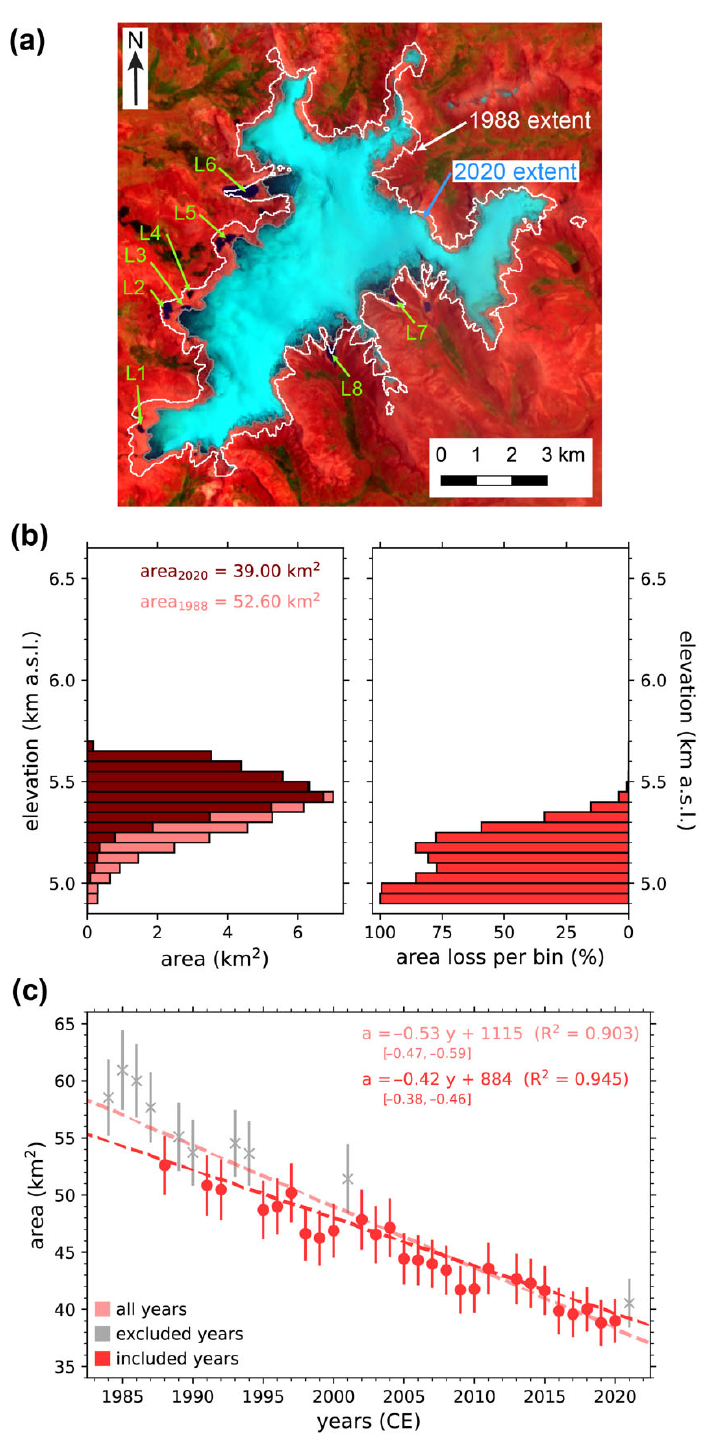
Figure 2. Changes at the Quelccaya Ice Cap ( a ) in map view, ( b ) with respect to elevation in 50 m elevation bins, and ( c ) over time. The Landsat scene for ( a ) is a false-color composite of the scene with the minimum area in 2020 (29 October), and the white outline is the 1988 extent for the scene with the minimum area (3 September). The green arrows indicate eight proglacial lakes (L1 through L8) that have emerged within the 1988 extent. In ( c ), ten years with anomalously larger ice cap areas are excluded (gray x’s), and linear regressions results are displayed for the remaining 22 years and the entire dataset, including the 95% confidence intervals inside the square bracket. The 2- σ uncertainty intervals are indicated by the error bars.